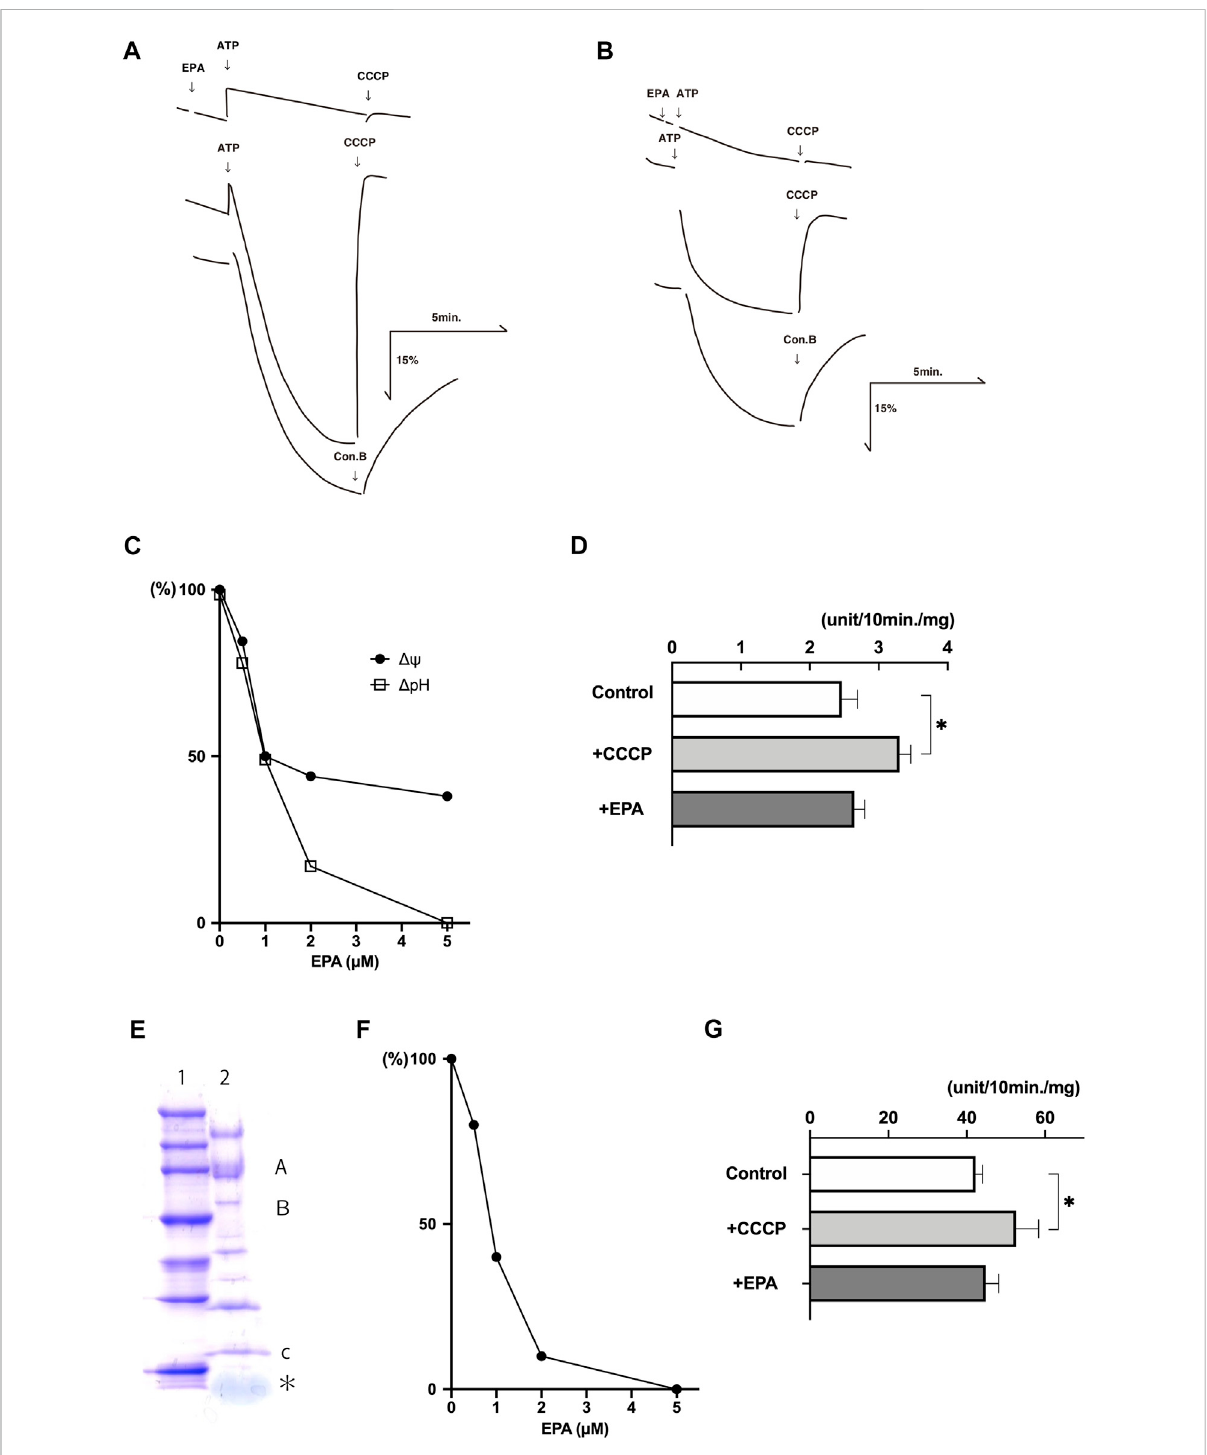
FIGURE 2 EPA uncouples ATP-dependent proton transport and ATPase activity in the chromaf fi n granule membrane vesicles and reconstituted proteoliposomes. Typical examples of the ATP-dependent formation of Δ pH (acridine orange fl uorescence quenching) (A) and Δψ (oxonol-V fl uorescence quenching) (B) in chromaf fi n granule membrane vesicles (20 μ g protein) were shown. Additions, ATP at 2 mM; EPA 5 μ M in (A) and 10 μ M in (B); CCCP, 1 μ M, con B 1 μ M. (C) . Dose dependence on the effect of EPA. Acridine orange ( □ ), oxonol-V ( C ). 100% corresponding to the fl uorescence intensity before adding ATP. An average of duplicate determinations. (D) The effect of EPA at 5 μ M and CCCP at 1 μ M on the Mg- ATPaseactivity.About60%ofthetotalATPaseactivitywassensitivetoconBat1 μ Mofthechromaf fi